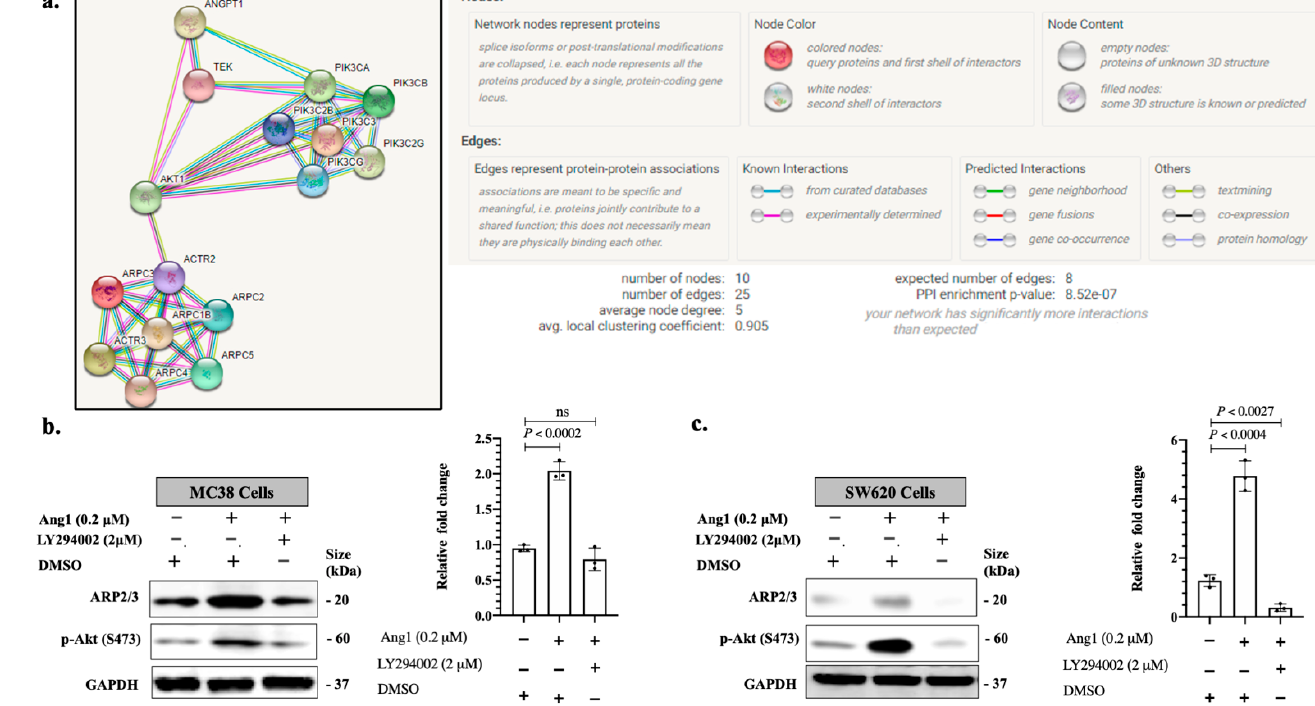
Figure 5. PI3K/AKT pathway contributes to Ang1-dependent ARP2/3 expression. ( a ) Protein interaction networks generated using STRING database version 11 showing the interaction between Ang1 (Angpt1), TIE2 (Tek), PI3Ks (PI3K), Akt (AKT1) and ARP2/3 subunits. ( b , c ) Western blotting of ARP2/3 expression in exposed MC38 or SW620 cancer cells to recombinant Ang1 in the presence or absence of PI3K/AKT inhibitor (LY294002). Right panels show the intensity of ARP2/3 bands that were quantified and normalized against GAPDH using ImageJ and represented as a fold change (n = 3). Data are presented as the mean ± SD. ns = Not significant.